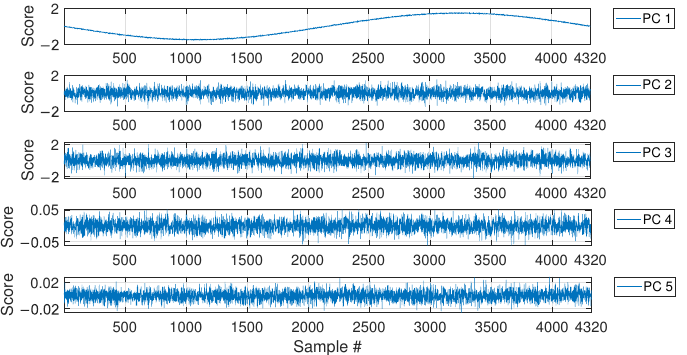
Figure 6. PC scores for the baseline set of eigenfrequencies containing a number b = 4320 of observations, considering a long-term temperature trend.